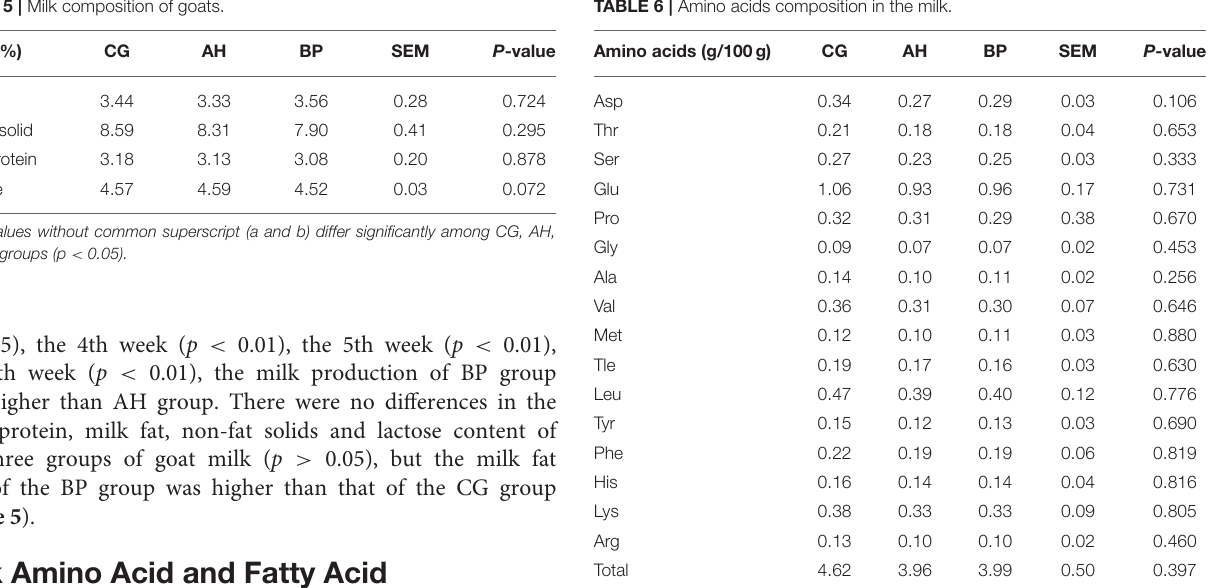
TABLE 4 | The changes in milk production of goats. Items Time point CG AH BP SEM P -value Milk production (kg/d)